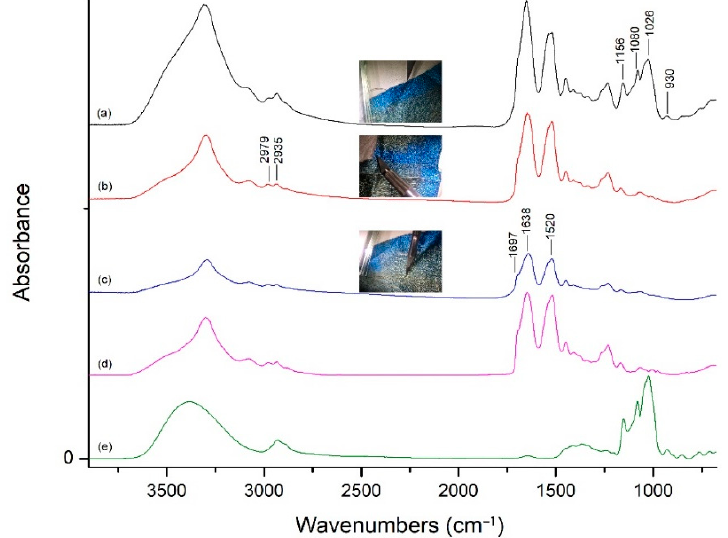
Figure 4. FTIR spectra of the curtain fabric: ( a ) unfaded outer border with adhesive; ( b ) unfaded inner edge without adhesive; ( c ) faded textile; and standard spectra of native mulberry silk ( d ) and starch ( e ).